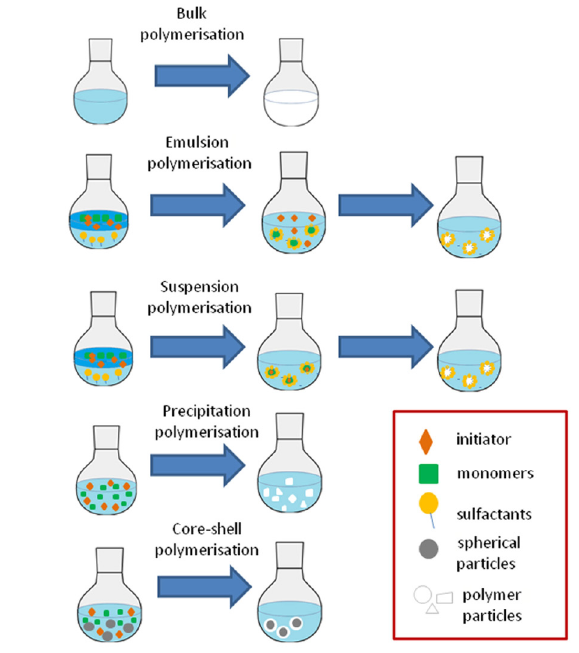
Figure 3: Different polymerization techniques used for MIP